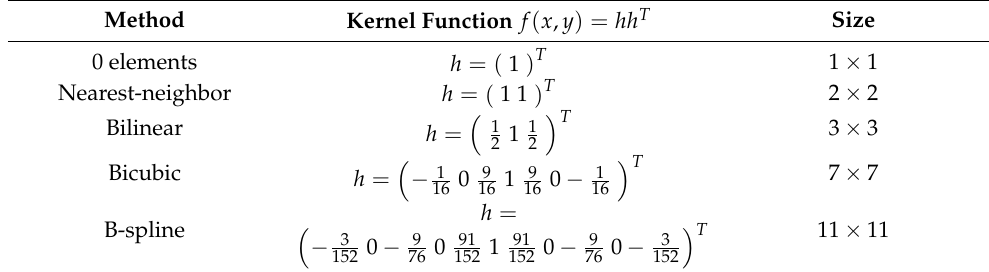
Table 1. The classical convolutional interpolation kernels [31].